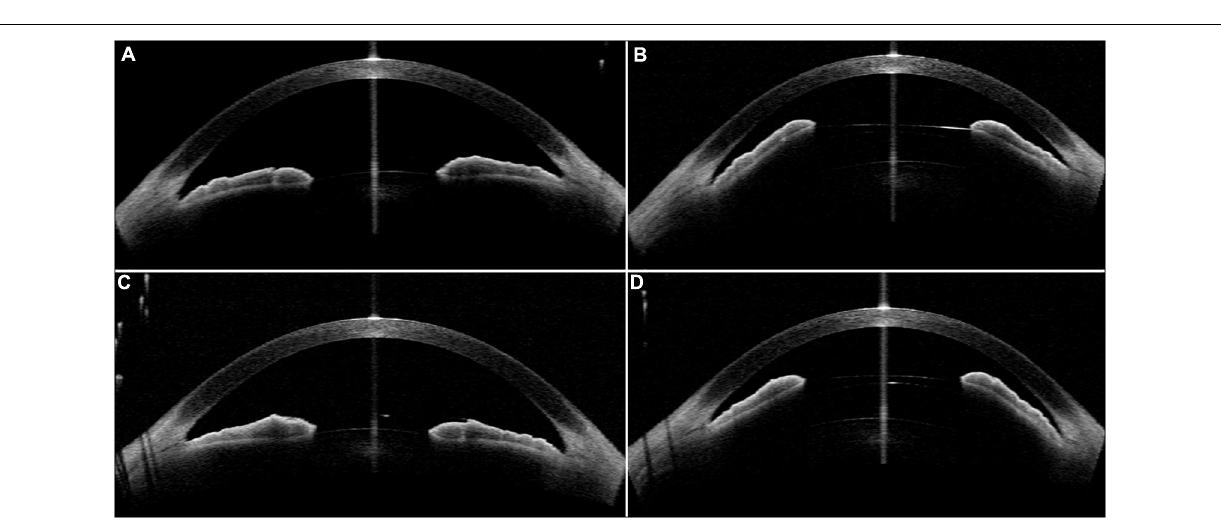
FIGURE 4 | Case 1: (A,C) Concave shape iris before surgery; (B,D) low vault was shown in both eyes 1 year postoperatively. (Row 1: right eye; Row 2: left eye).